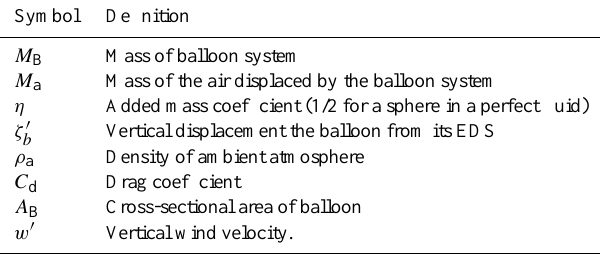
Table 2. Atmospheric and balloon parameters in the Antarctic lower